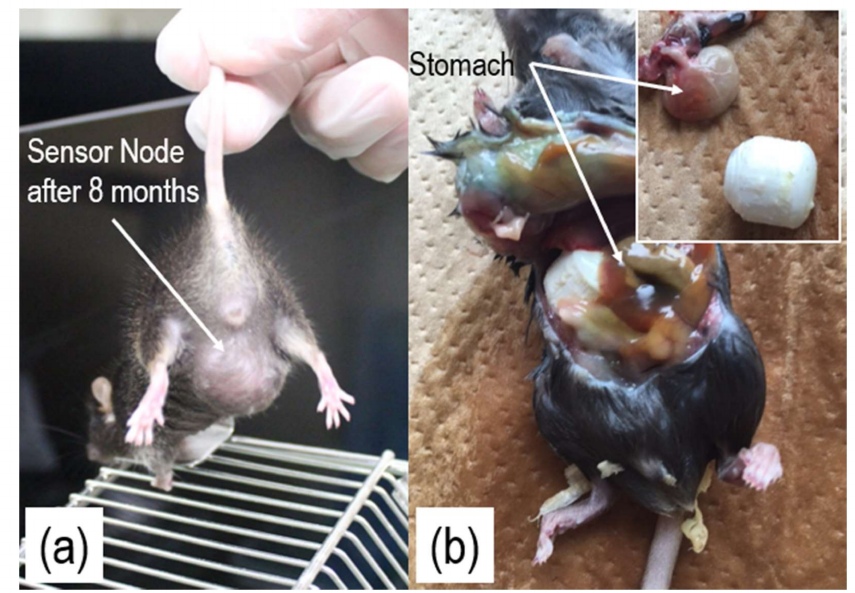
Figure 5. Photo of a mouse eight months after the implantation ( a ), and photos of dissection after the mouse had been found dead a few days after the implantation ( b ).